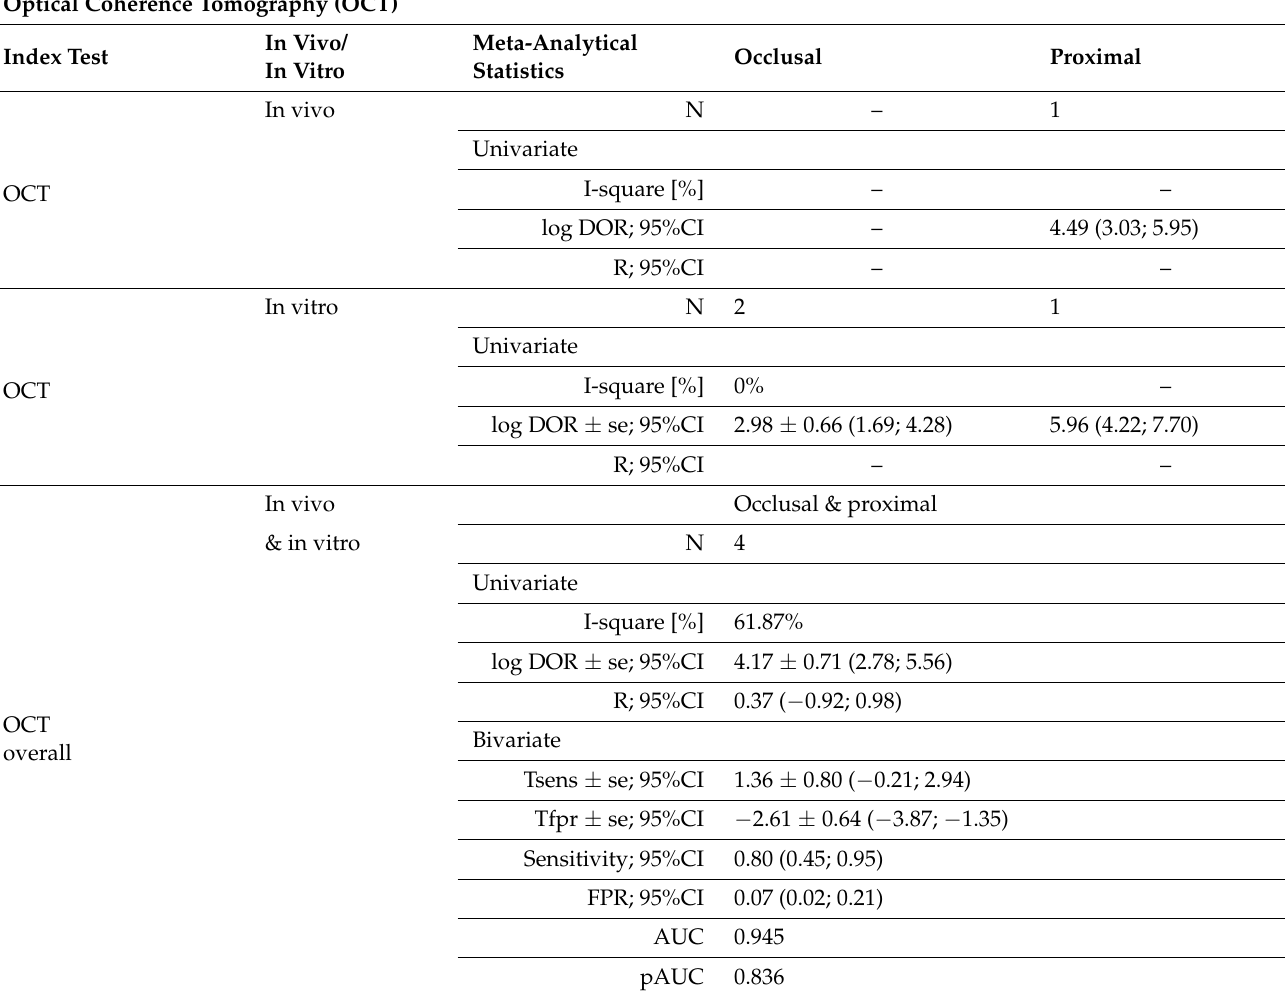
Table 5. Meta-analytical results for the optical coherence tomography (OCT) test. For this technology, supplemental comprehensive meta-analysis was conducted on the four identified studies (including graphs), irrespective of their review